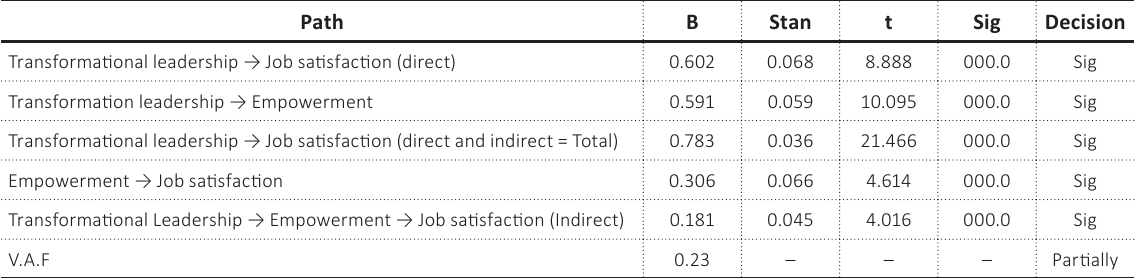
Table 12. Relationship between transformational leadership and job satisfaction through empowerment